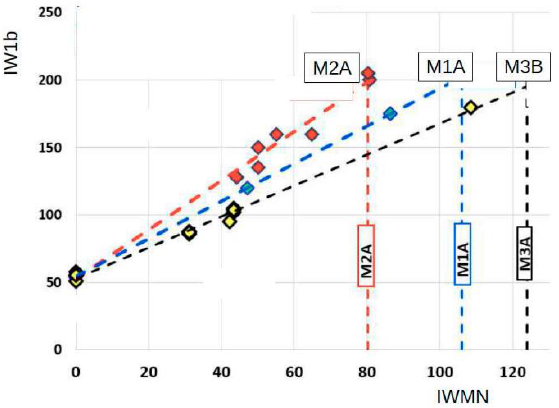
Figure 9. Graph of the values of IW 1 b corresponding to the machines whose data were analyzed.